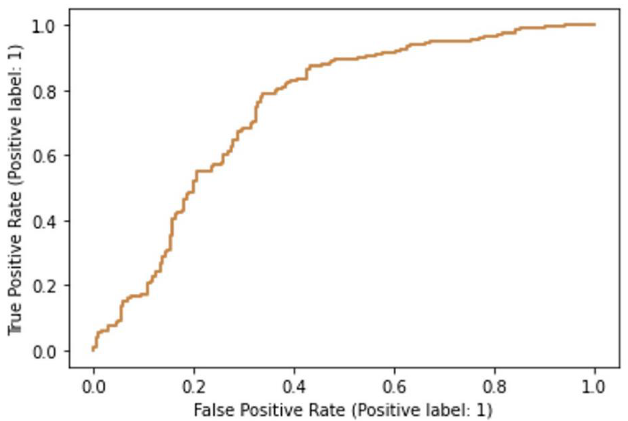
Figure 5. Receiver operating characteristics curve for the support vector machine model.